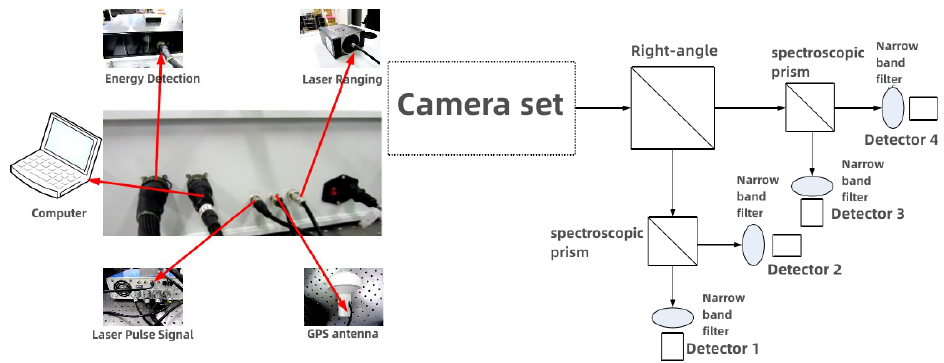
Figure 3. Hardware connection diagram and system experiment schematic diagram.